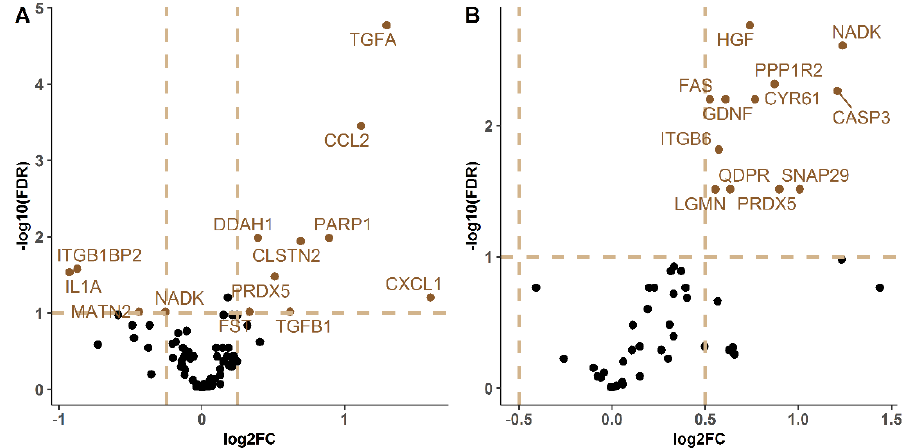
Figure 2. Volcano plot of significant proteins in the BALF ( A ) and lung ( B ) analyses of ischemic vs. sham animals. The X -axis represents the logFC and the Y-represents the logarithm in base 10 of the False Discovery Ratio (FDR). The horizontal line symbolizes an FDR < 0.1 and the vertical lines symbolize an FDR > |0.25|. Proteins over or under the mentioned cut-off points for FDR and FC represent the differentially expressed proteins and are marked in brown. A total of 12 proteins (BALF) and 14 (lung) showed differential expression between ischemic and sham animals. LogFC: logarithmic fold-change, FDR: false discovery ratio. Table 1. Top table of BALF (left) and lung homogenate (right) protein expression . Significant pro- teins are shown. The p -value column corresponds to the unadjusted p -value. logFC: logarithmic fold-change, FDR: false discovery ratio.